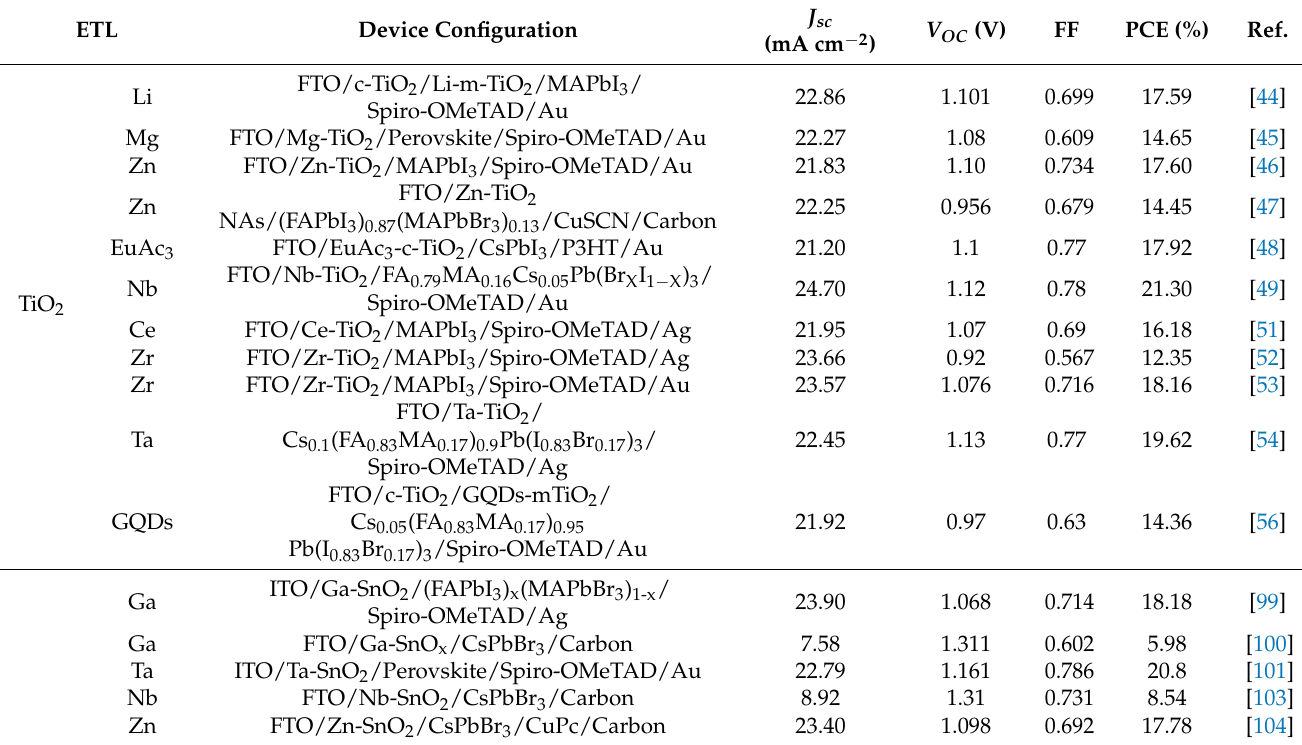
Table 1. Summary of various PSCs performances using doped